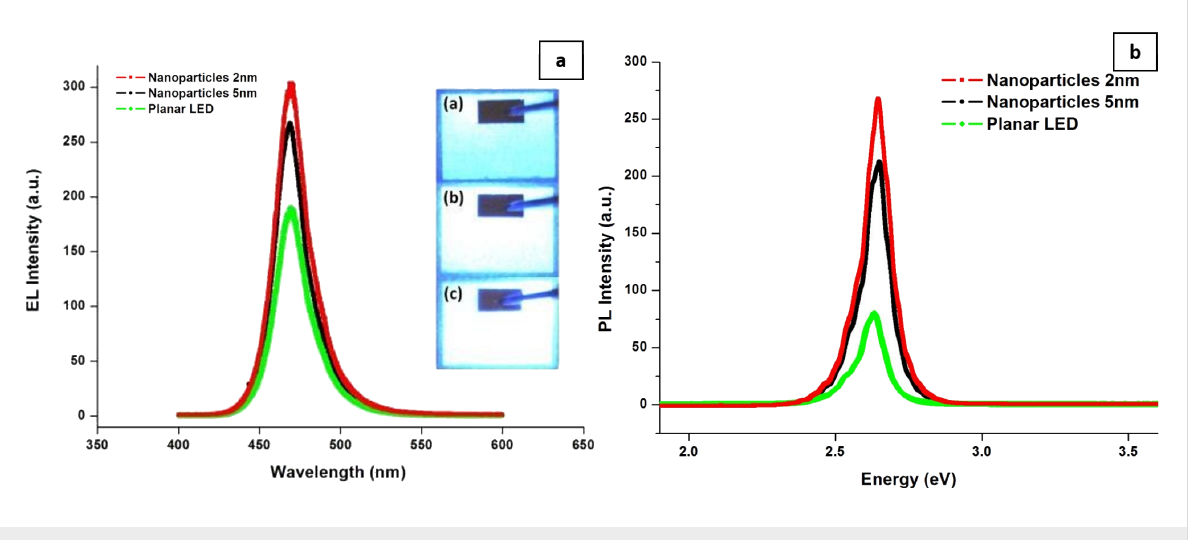
Figure 4: (a) EL spectra of LED having 2 and 5 nm Au–CNT system with an injection current of 100 mA measured at room temperature, using a planar LED as reference. The inset shows the optical images (a) without AuNP, (b) 5 nm Au–CNT system, and (c) 2 nm Au–CNT system. (b) Room temperature PL spectra of GaN LED with a 2 and 5 nm Au–CNT system and a planar LED as reference. Figure 4a and Figure 4b were adapted from [45] (“Enhanced optical output power of blue light-emitting diodes with quasi-aligned gold nanoparticles“, © 2014 Y. Jin et al., distributed under the